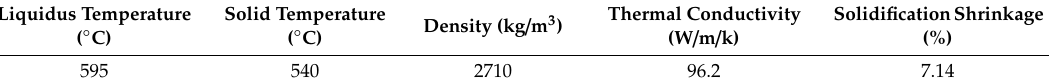
Table 2. Properties of the AlSi 9 Cu 3 (Fe) aluminium alloy.